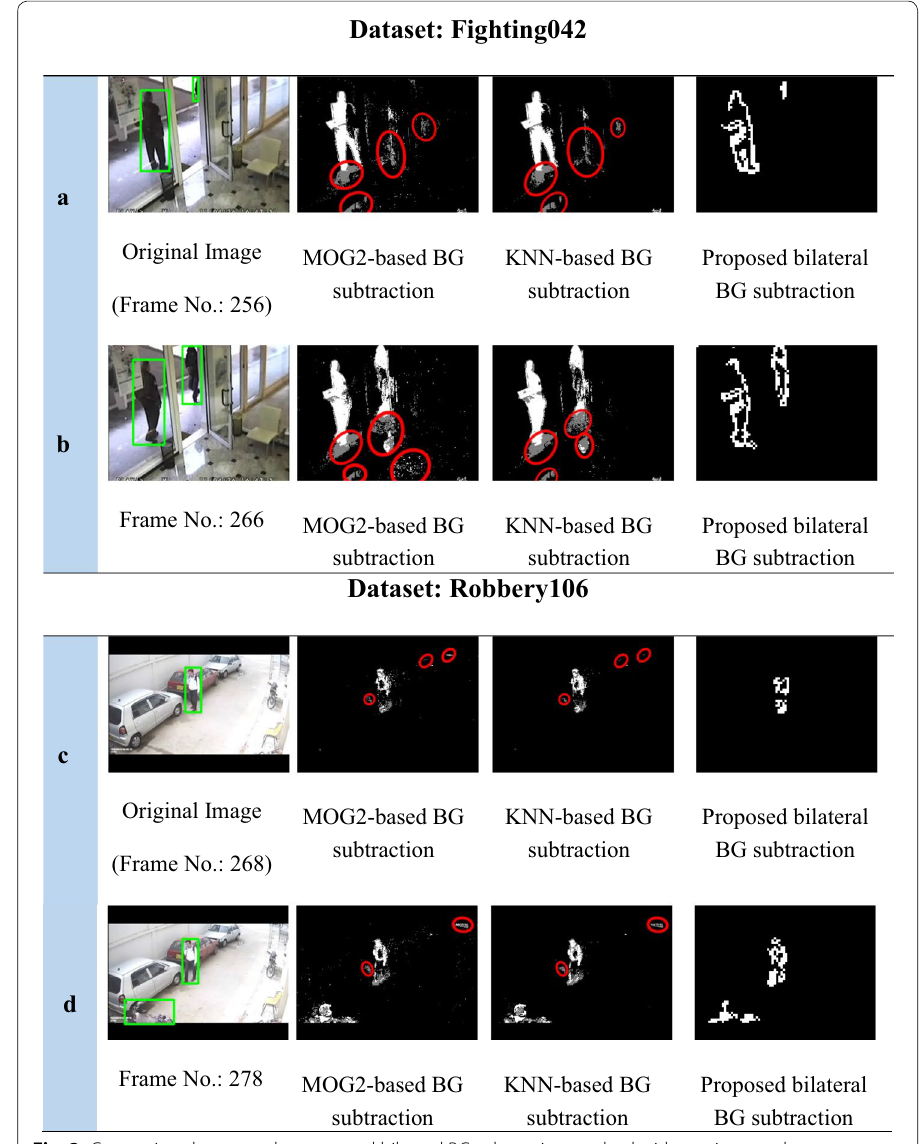
Fig. 2 Comparison between the proposed bilateral BG subtraction method with previous